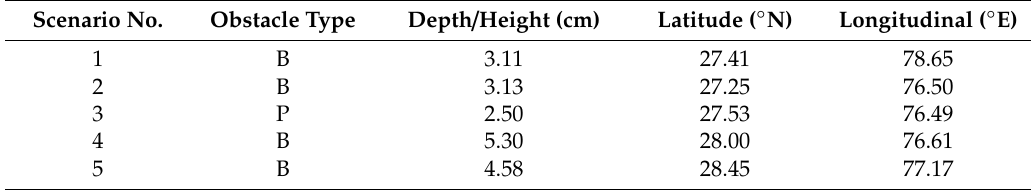
Table 8. Information of pothole (P) and bumps (B) collected by manual inspection for the R2 test site. Scenario No.